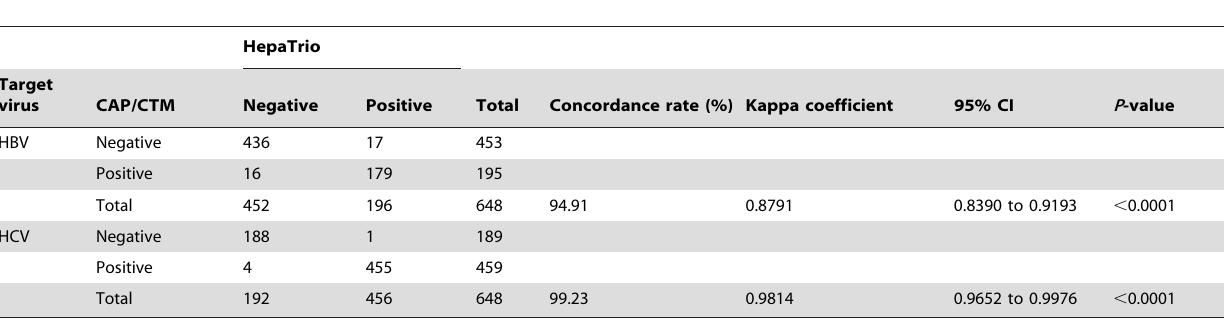
Table 1. Agreement between the results of the HepaTrio test and the CAP/CTM HBV and HCV assays.